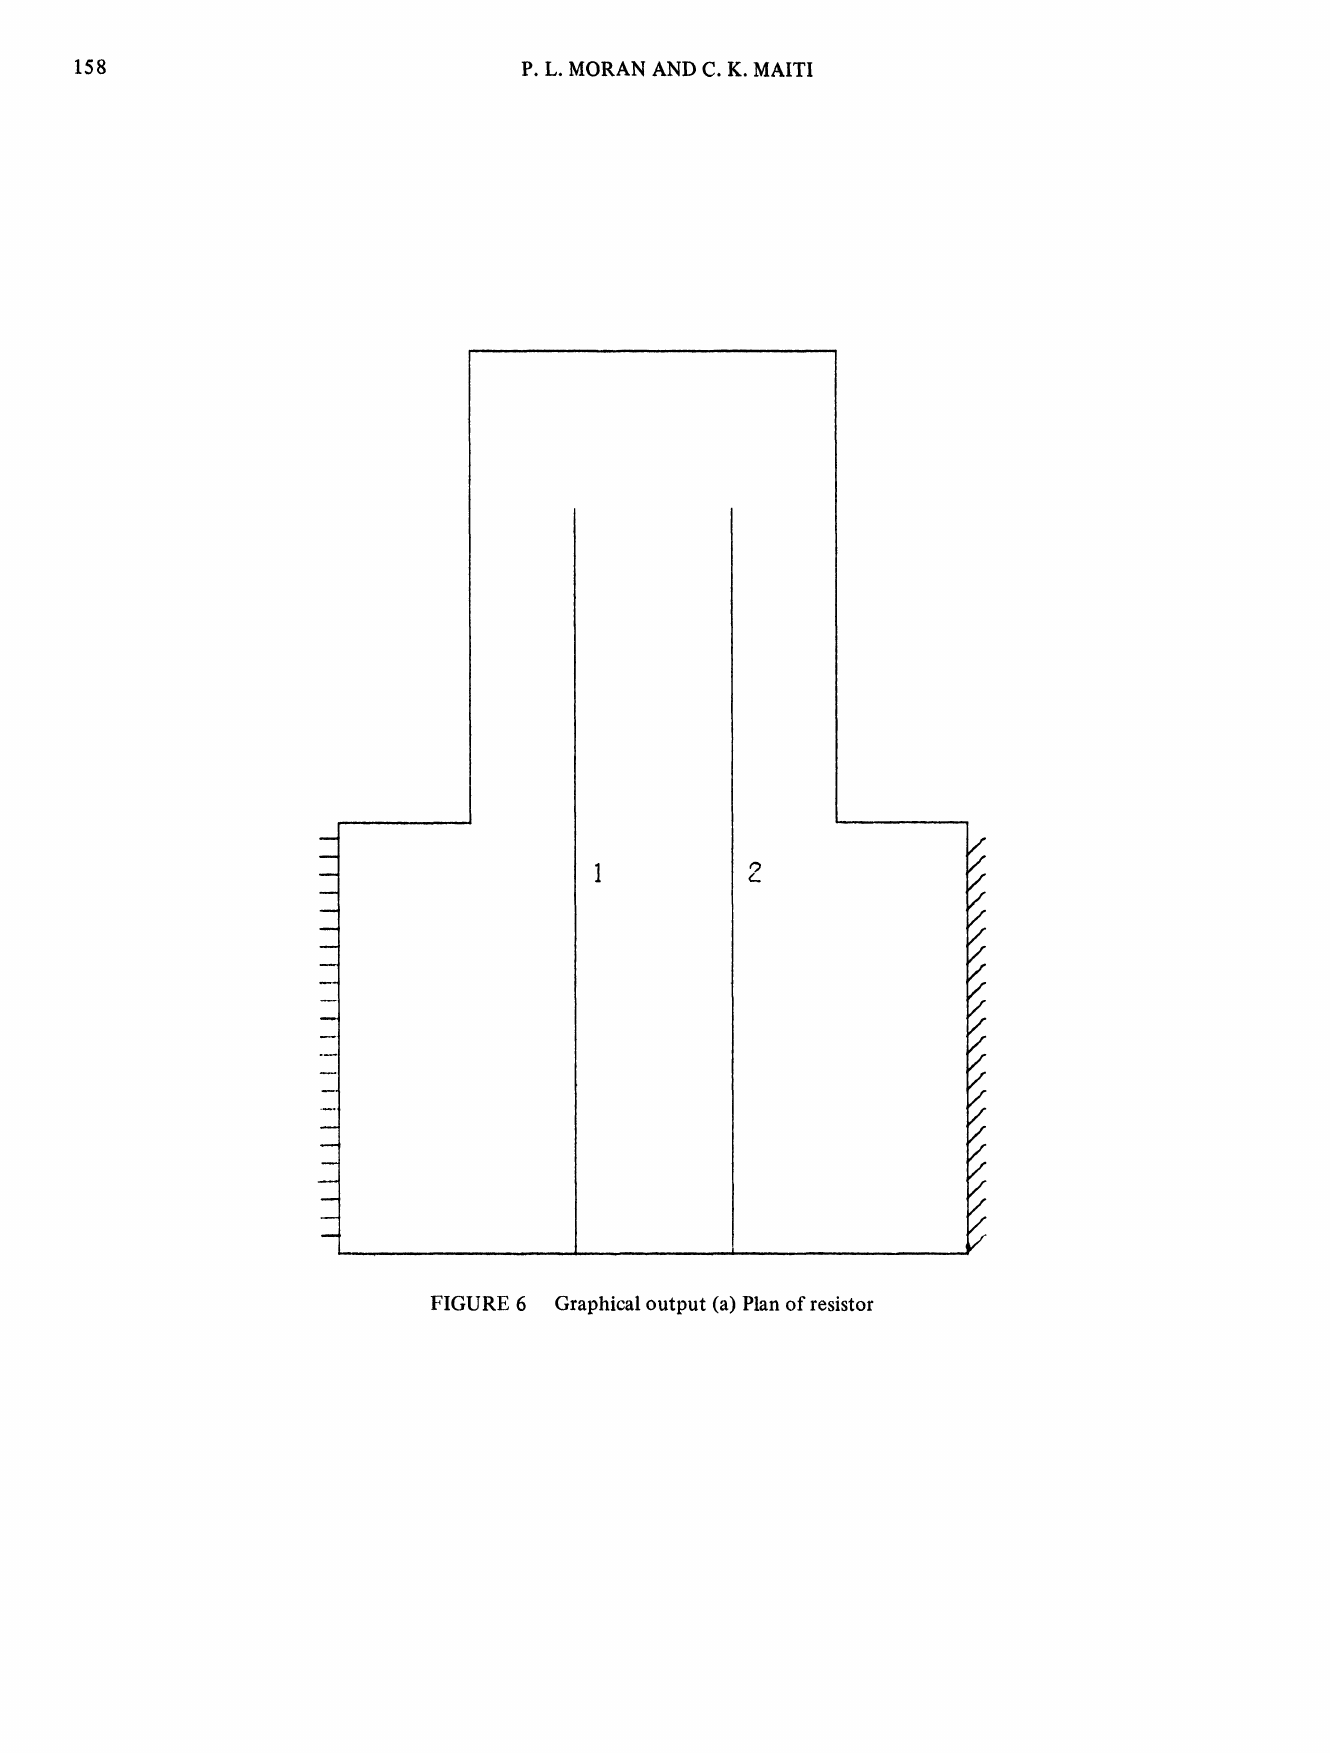
FIGURE 6 Graphical output (a) Plan of